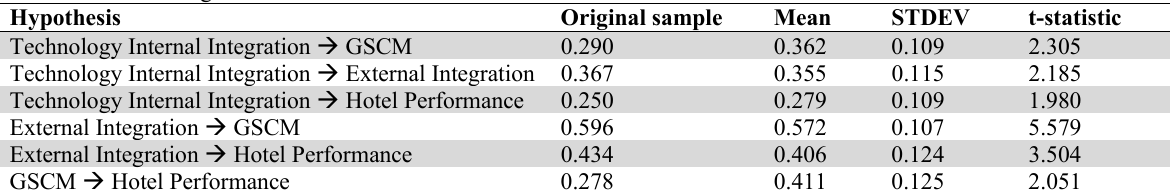
Results for Inner